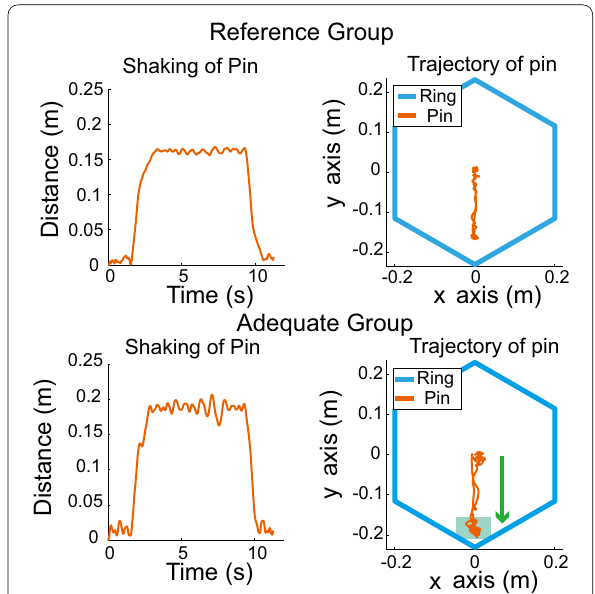
Fig. 19 Optimized experiment result of HILS on circular operation (follower 1)